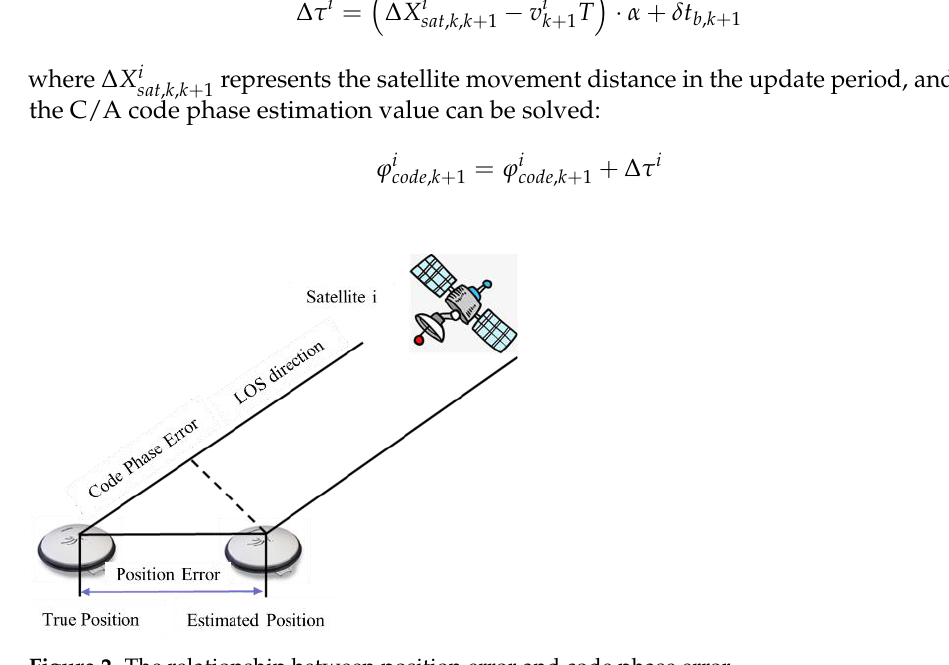
Figure 2. The relationship between position error and code phase error.